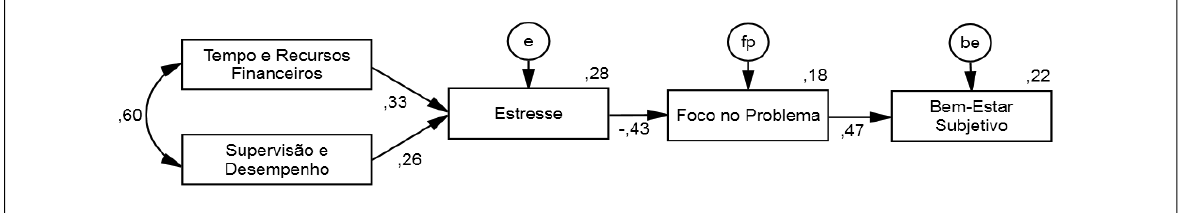
Figura 2 . Modelo 2 (Final) do Bem-Estar Subjetivo de Mestrandos e Doutorandos na Pós-Graduação. Com efeito, obtiveram-se evidências substanciais da adequação do modelo 2 após as modi fi cações, sendo que todas as regressões agora foram signi fi cativas ( p <